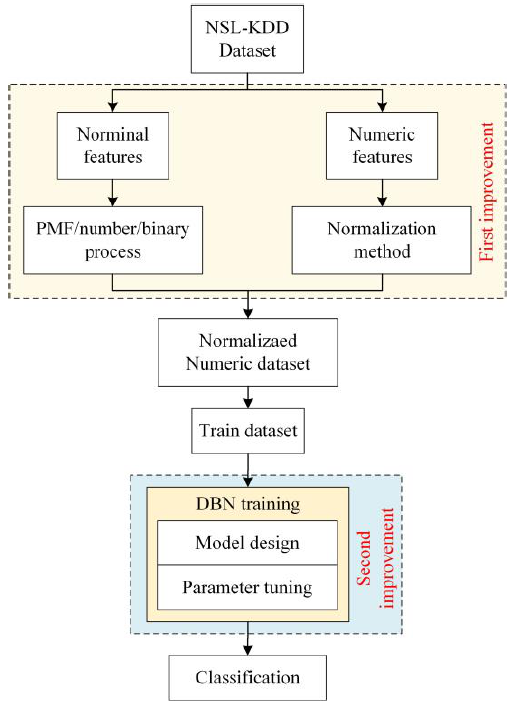
Figure 2. The improvement process of DBN.